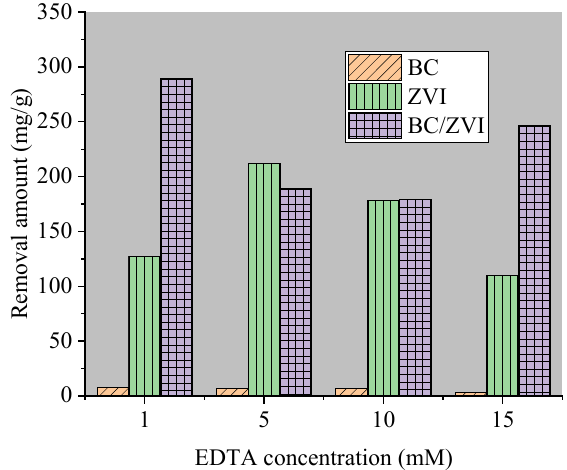
Figure 7. Effect of EDTA on TC removal effect of BC composites.